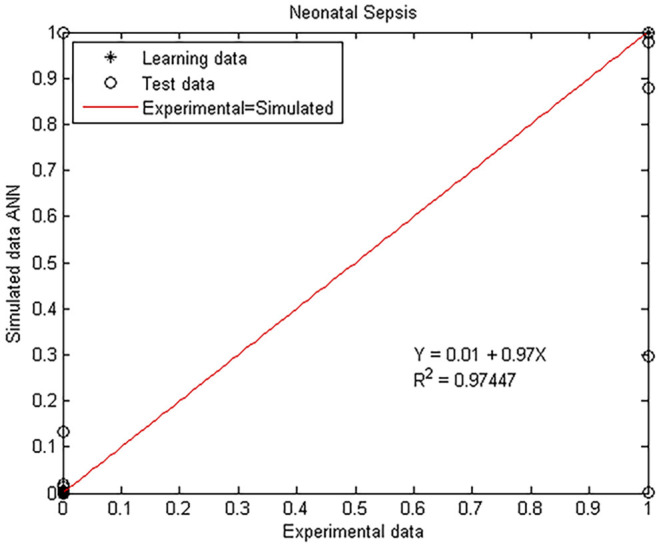
Experimental vs. ANN simulated values for sepsis estimation on the day of clinical diagnosis. Scatter plot of the model where open circles and closed diamonds show experimental and learning data, respectively, and red lines indicate the linear regression model on scatter points.